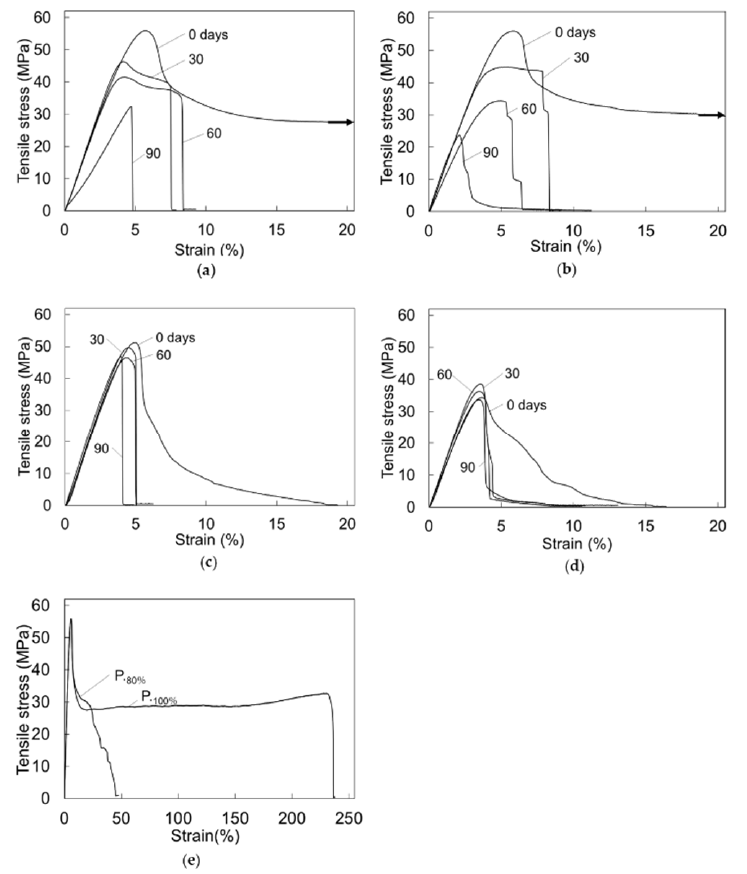
Figure 6. Representative changes of the stress–strain curves of the tensile test pieces after immer- sion for certain periods. ( a ) P. 100% , ( b ) P. 80% , ( c ) C. 100% , and ( d ) C. 80% . ( e ) Full curves of P. 100% and P. 80%